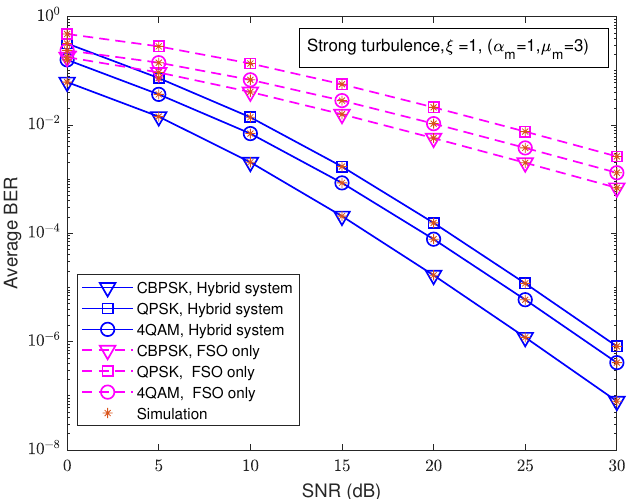
Figure 2. The relationship between BER and SNR of the hybrid system and single FSO system under different modulation mo des.